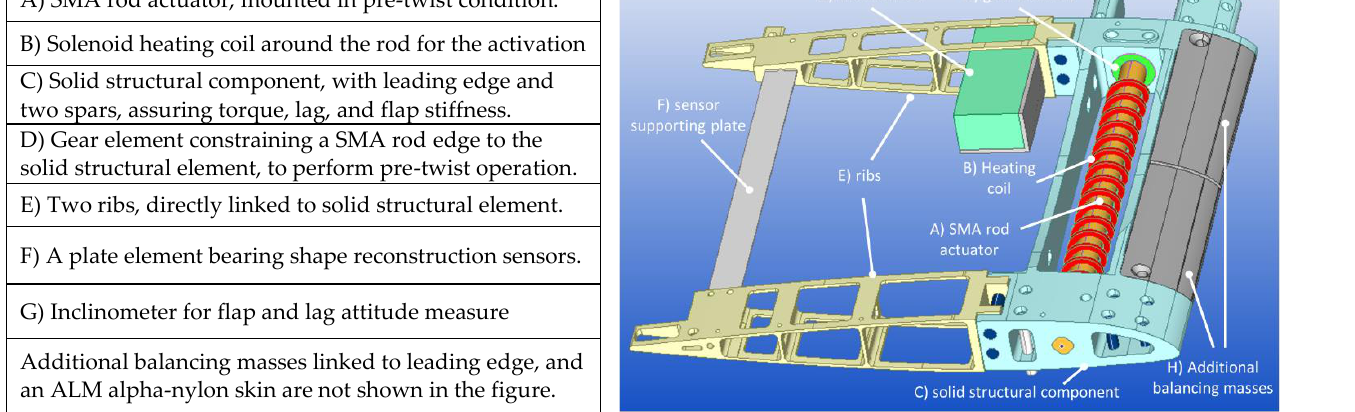
Figure 9. Main components of the adaptive twist blade architecture.